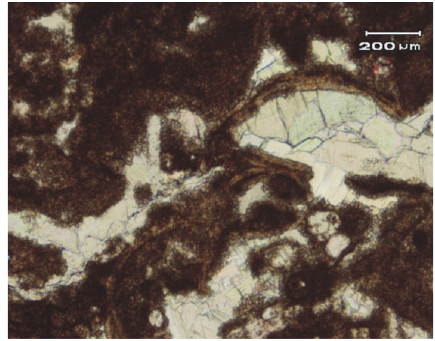
Figure 3: Gypseous dolarenite, S1, 3575.24 ∼ 3575.56 m, T 1 j 2 .